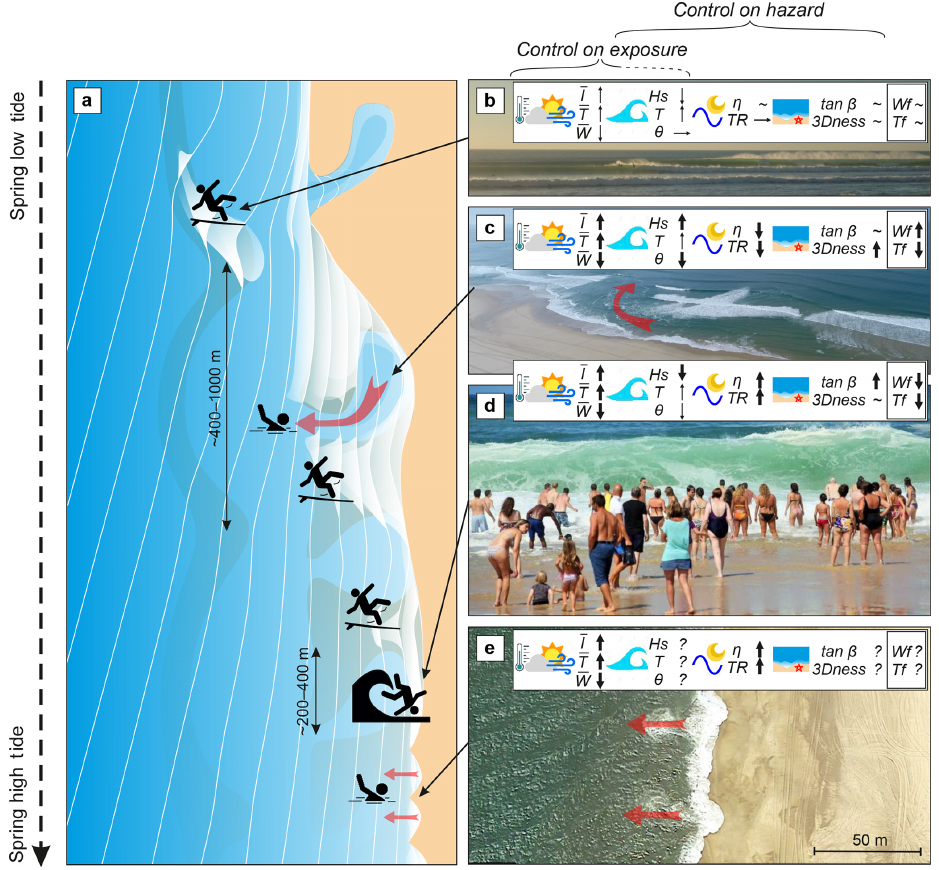
Figure 17. (a) Primary surf zone life risks along the sandy surf beaches of southwestern France with (b) high-risk surfing activity throughout the tide cycle. (c) Channel rips primarily flowing between low tide and mid-tide and maximised for near-shore-normal long-period swell. (d) Hazardous shore-break waves primarily occurring at high tide on the steepest section of the beach and (e) small-scale swash rips flowing through the centre of beach cusps at spring high tide. The primary environmental controls on beachgoer exposure and surf zone hazard are synthesised in the top boxes in panels (b) – (e) , with bold arrows, “ ∼ ” and “?” indicating strong, absent and unknown control, respectively. Wave and morphological controls on swash rip life risk were not addressed here as it was not possible to discriminate from channel